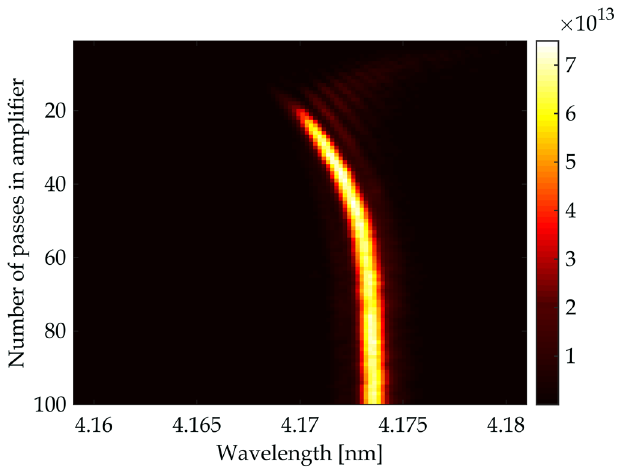
FIG. 16. All spectra for the 4.17 nm output radiation simu- lations. One can see that during the start-up process, the spectral distribution shifts to longer wavelengths, where it eventually stabilizes. Due to the initial conditions, the system needs more roundtrips to stabilize. The color represents the radiation intensity in arbitrary units. As in Fig. 14, a wavelength range of (cid:2) 3 ρ around the central wavelength of the single-pass HGHG is